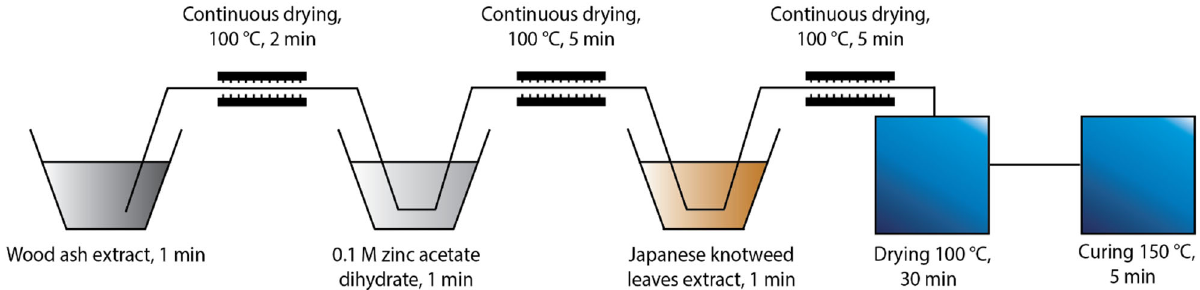
Figure 2. Schematic presentation of the Ash + 0.1 ZnAc + Extr protocol of the in situ synthesis of ZnO ‐ NP on cotton.